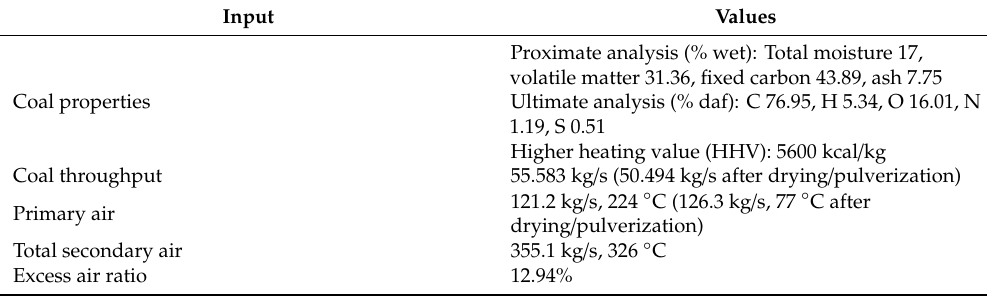
Table 1. Operating conditions of the 500 MWe coal-fired boiler.